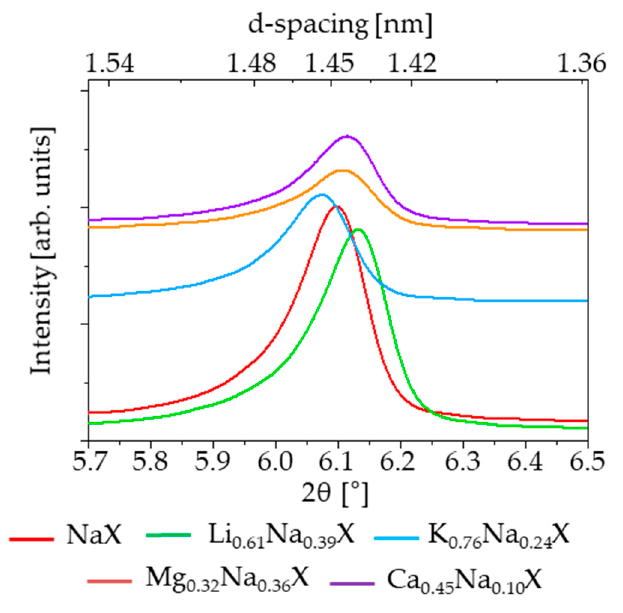
Figure 5. Diffraction patterns of investigated zeolite samples.